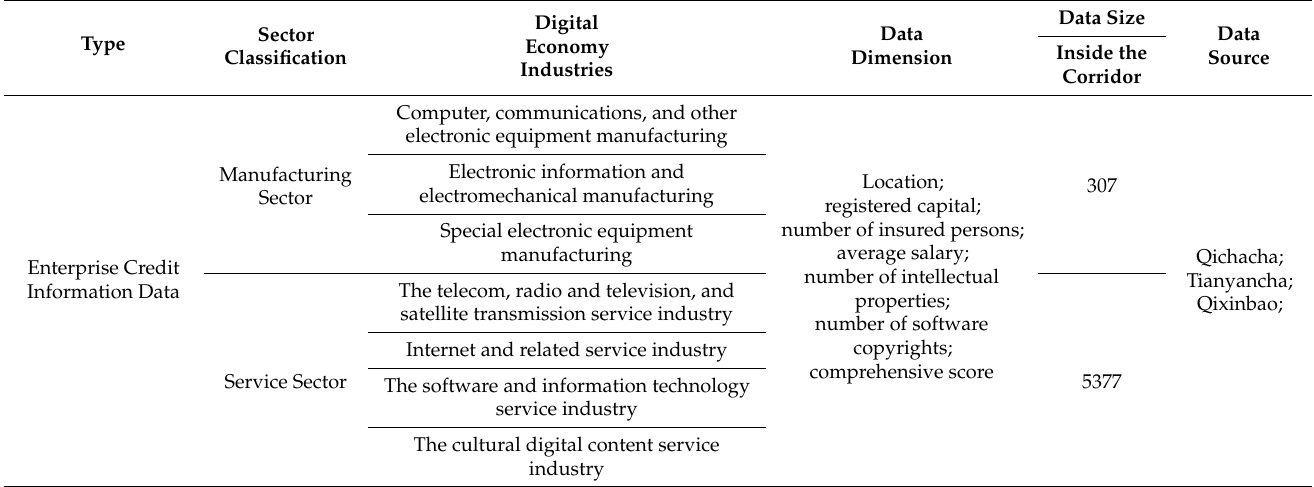
Table 2. Information of development data of